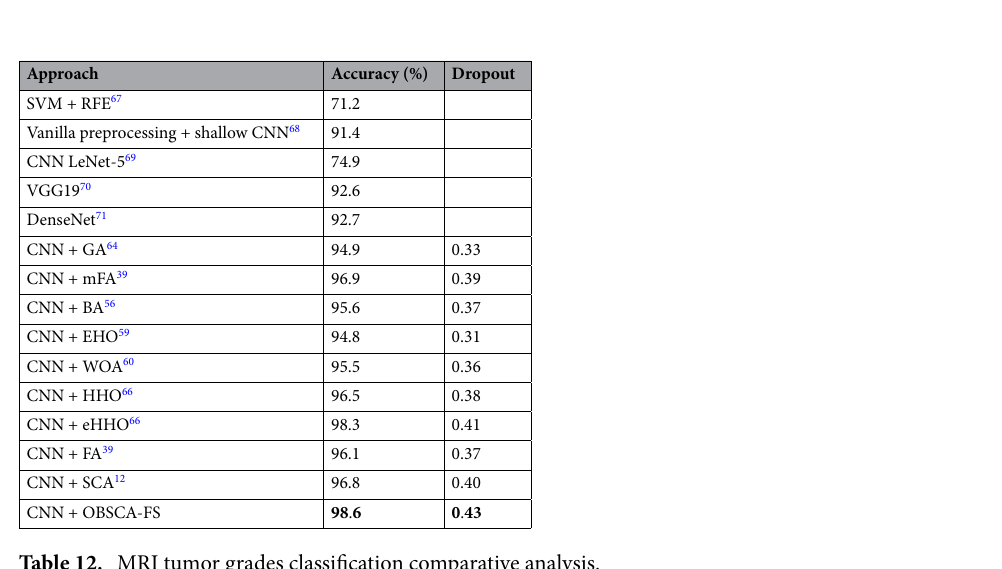
Table 12. MRI tumor grades classification comparative